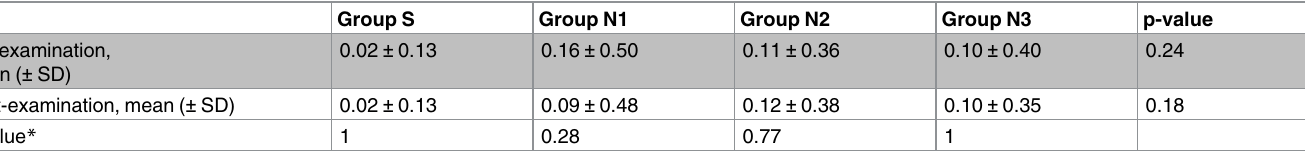
Table 4. Visual analog scale scores.